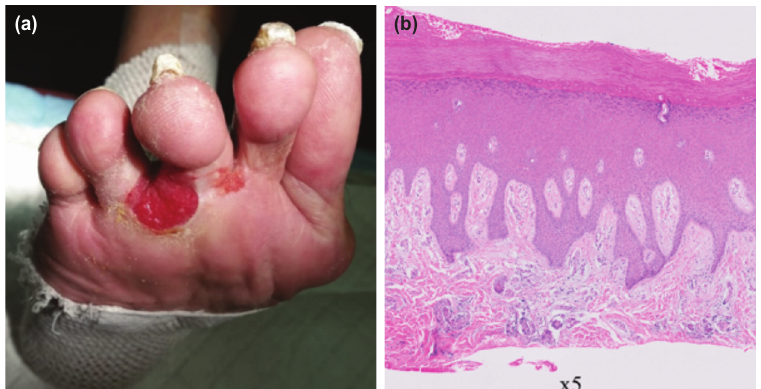
(a) Case 1 on initial presentation showing a superficial ulcer over the plantar aspect of the 3rd and 4th toe web space. (b) Fig. 1: Histology section showing acanthosis with marked compact orthokeratin, in keeping with acral location, no dysplasia or malignancy seen.